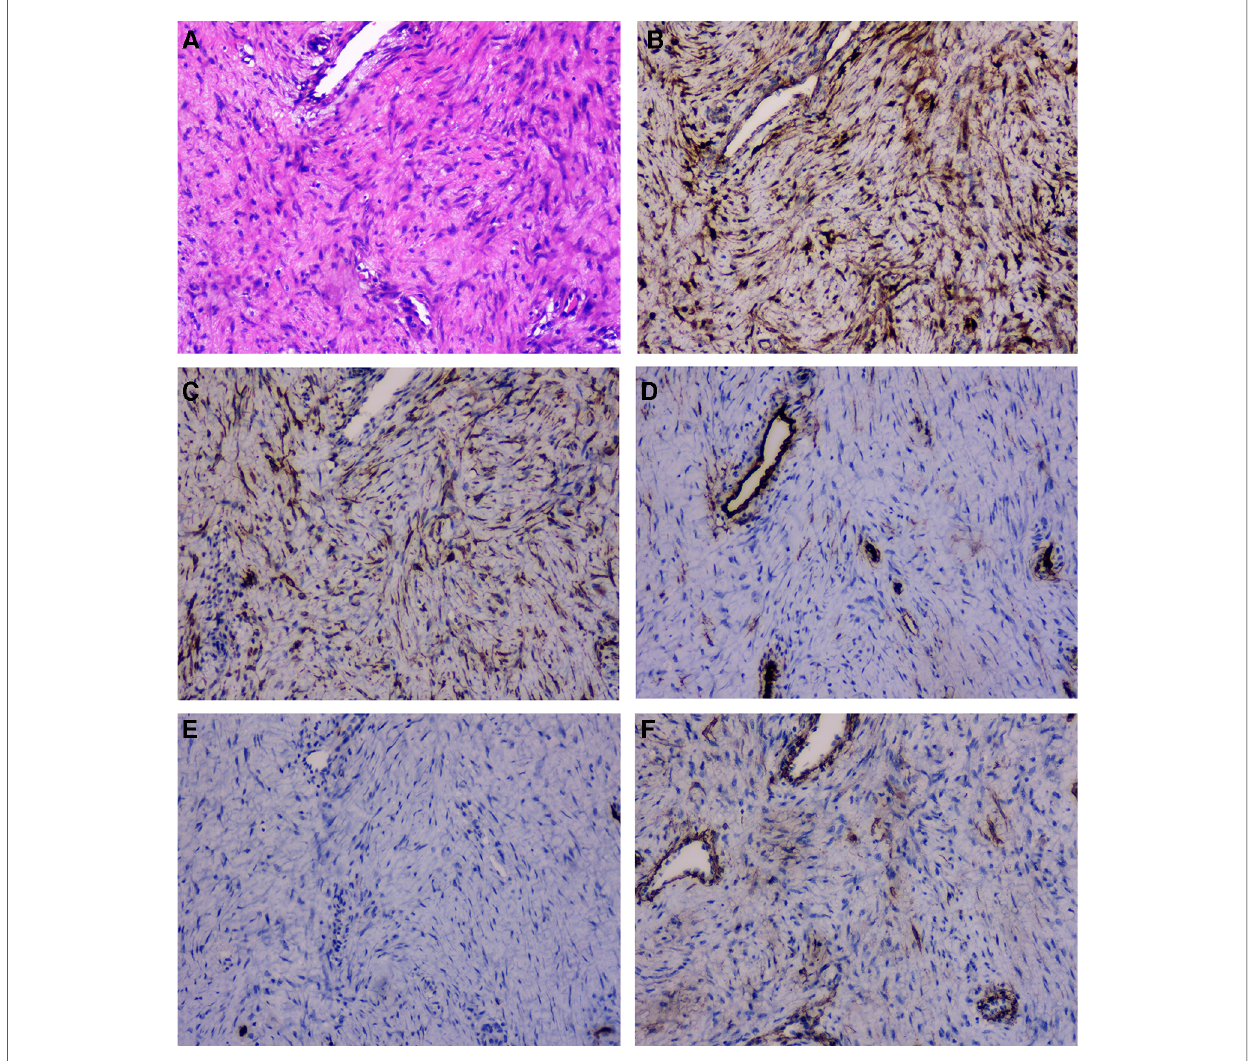
FIGURE 3 The tumor was composed of spindle cells ( A , HE X100). Immunohistochemistry showed the spindle cells were positive for β -catenin ( B , X100) and Desmin ( C , X100), negative for CD34 ( D , X100), S-100 ( E , X100), SMA ( F ,